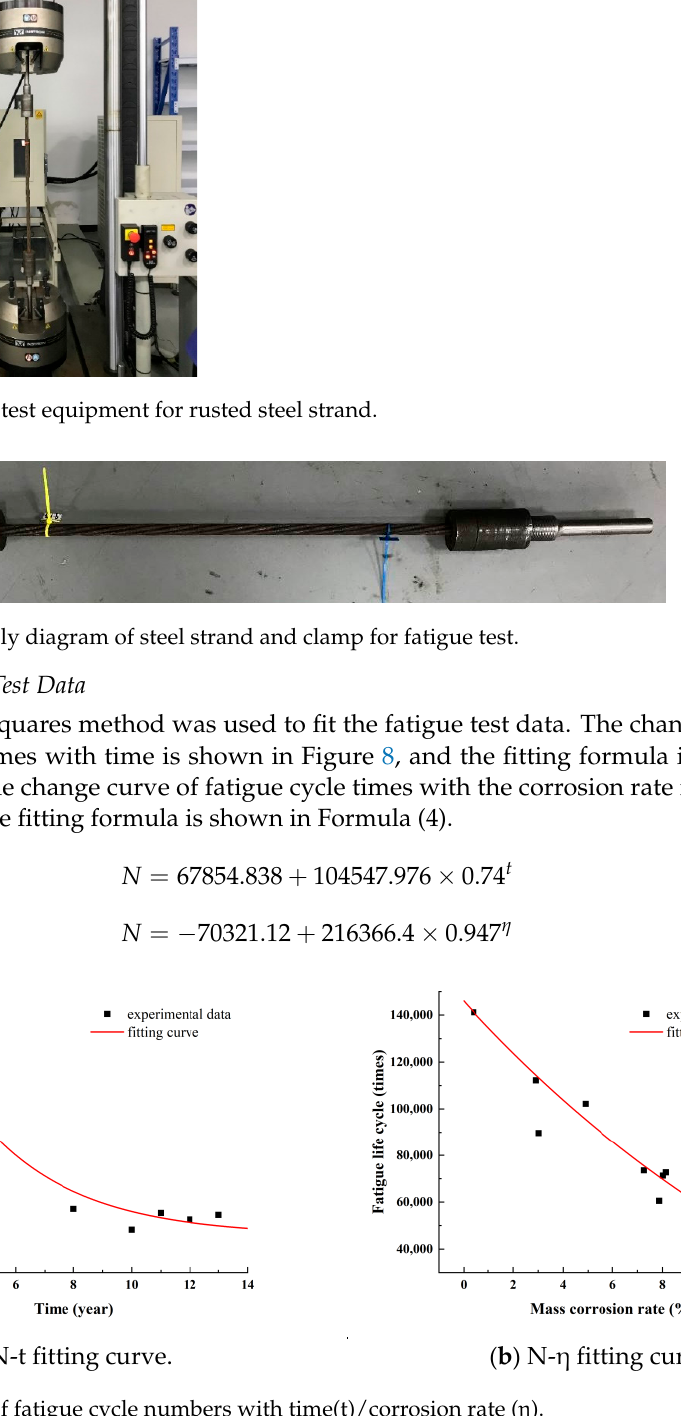
Figure 8. Curve of fatigue cycle numbers with time(t)/corrosion rate (η).